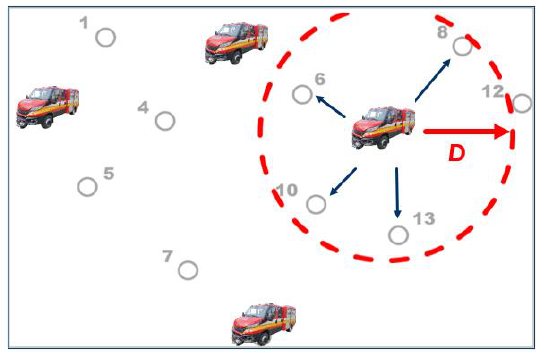
Figure 2. Visualization of fairness approach parameters.